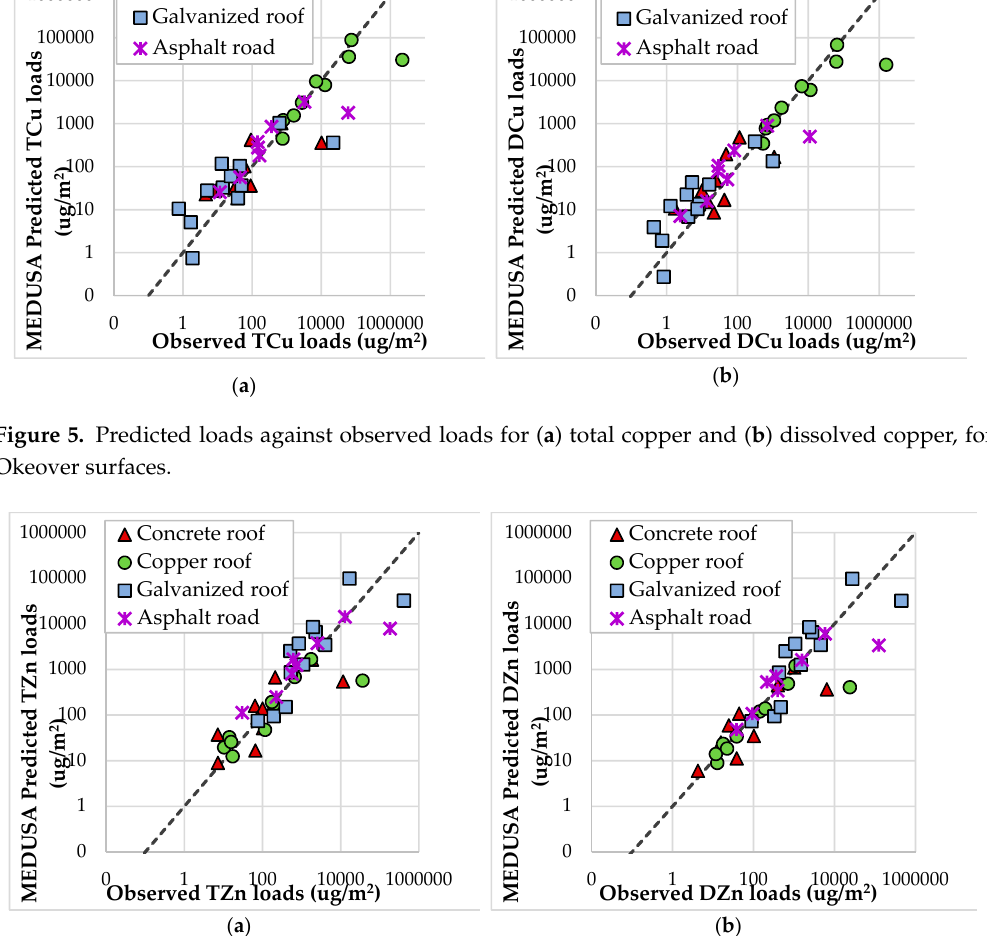
Figure 6. Predicted loads against observed loads for ( a ) total zinc and ( b ) dissolved zinc, for Okeover surfaces.